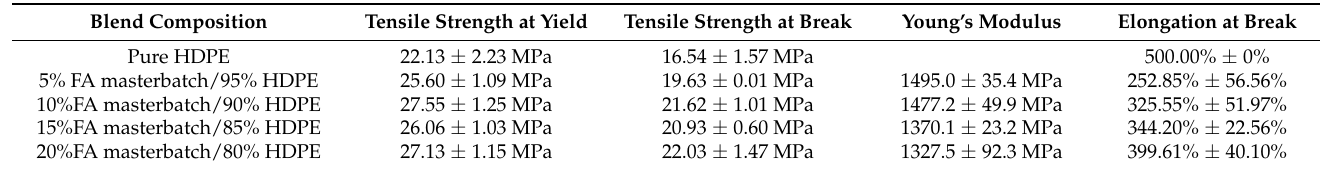
Table 3. Effect of FA on tensile properties of